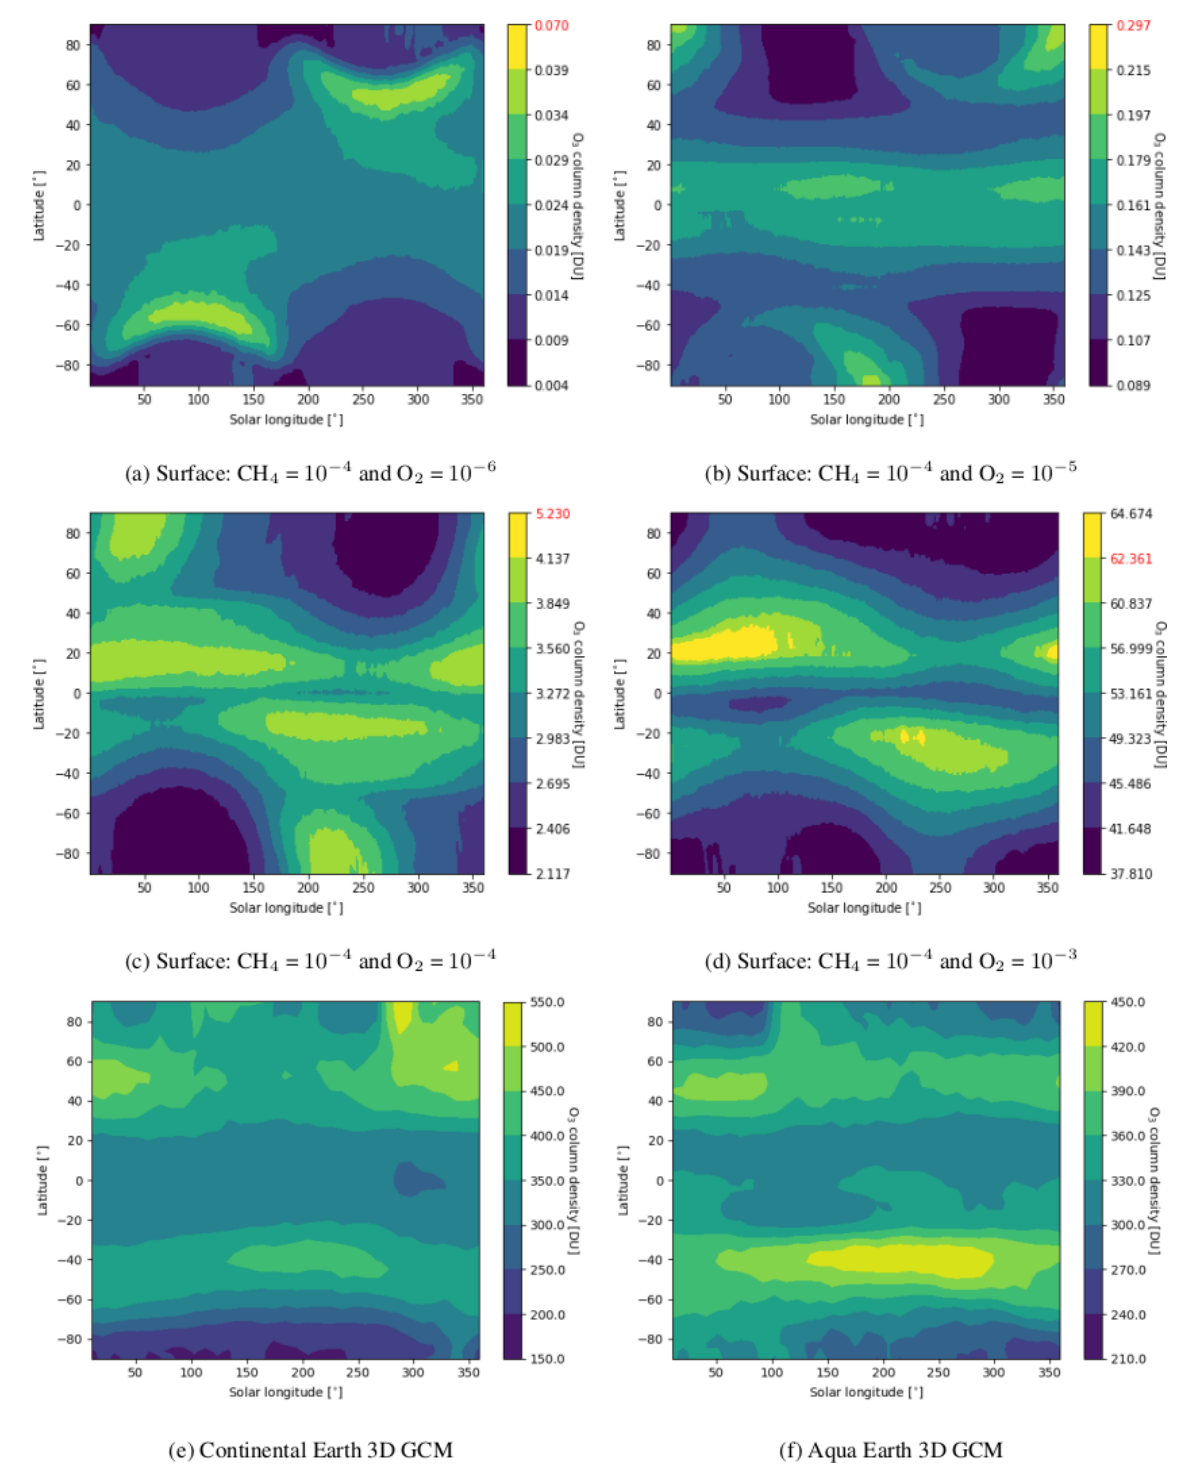
Figure 6. Ozone column density zonal mean over 13 years for early Earth as well as over 1 year for an actual simulated continental Earth and aqua Earth. 1D simulated early Earth values are highlighted in